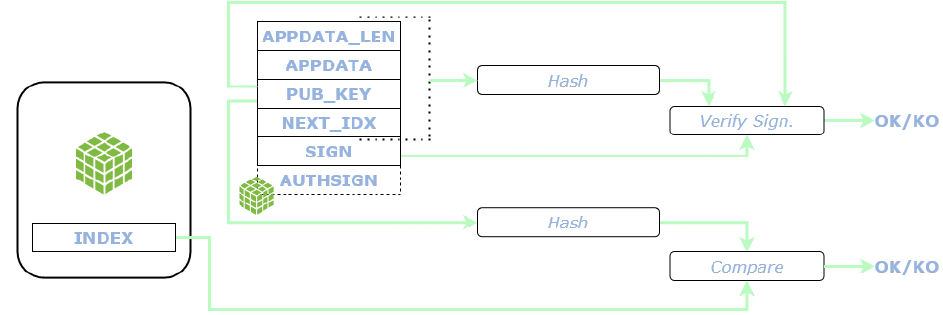
Figure 5. Verifications of an L2Sec message.